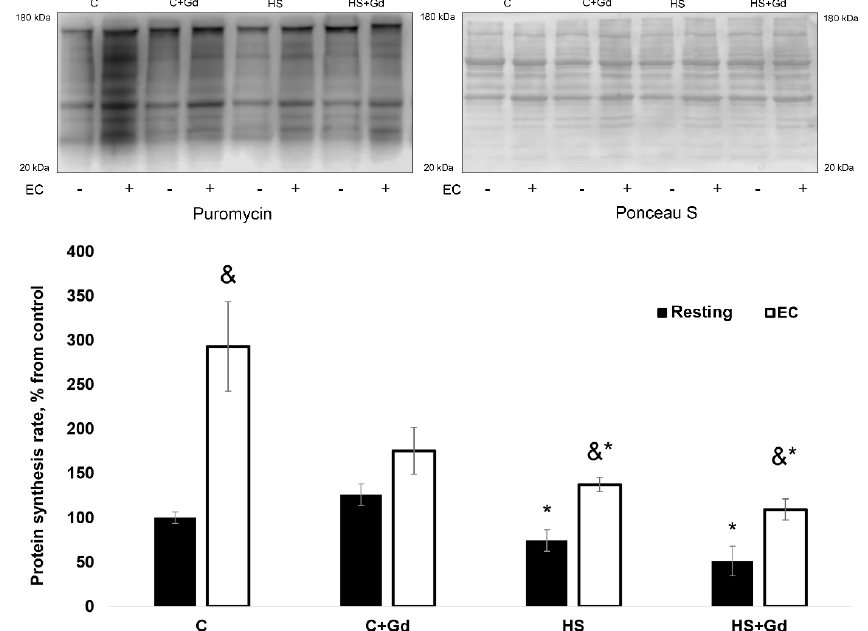
Figure 4. The effect of SAC blockade on the rate of protein synthesis in the eccentrically-contracted rat soleus muscles following 7-day hindlimb unloading (experiment 2). Values are means ± SEM, expressed relative (%) to the control resting muscle; n = 7/group. C—control animals, C + Gd—control animals with GdCl 3 treatment of the isolated soleus, HS—animals subjected to 7-day hindlimb unloading, HS + Gd—hindlimb-unloaded animals with GdCl 3 treatment of the isolated soleus. The data were analyzed using 3-way ANOVA with post hoc Tukey. The main effect of HS p = 1,51656E-06, the main effect of EC p=3,23095E-08, the main effect of Gd treatment p = 0,000187; interaction effect p = 0,000731; *—significant difference vs. C group ( p < 0.05), &—significant difference from the resting muscle of the same group ( p < 0.05). Black bars—resting muscle, white bars—eccentrically-contracted